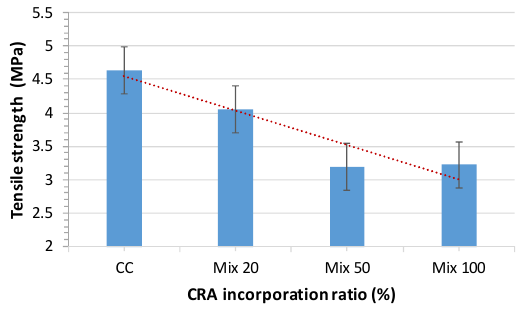
Figure 15. 28-day tensile strength test results.